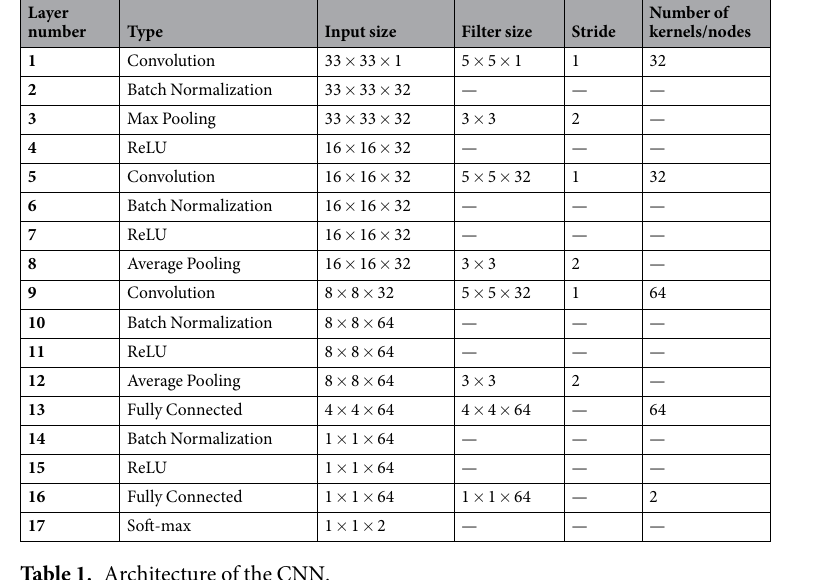
Table 1. Architecture of the